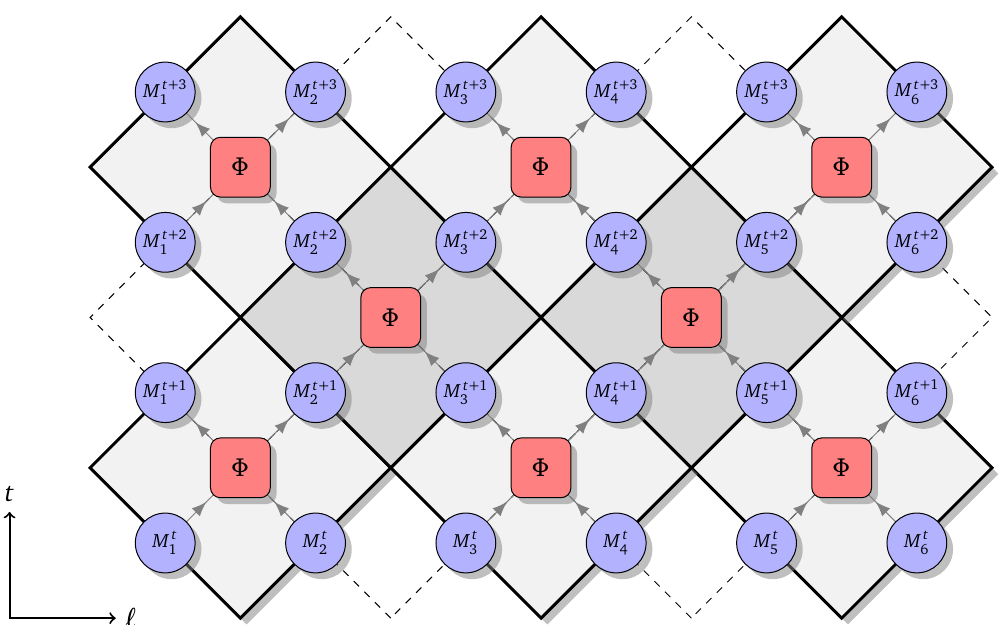
Figure 2: Fabric of discrete space-time: the physical space-time lattice, comprising matrix degrees of freedom M t (blue circles), coexisting with the light-cone square lat- (cid:96) tice depicted by a tilted checkerboard. A two-body symplectic map Φ τ (red square), which is attached to the middle of each tile, provides the time-propagator for every pair of adjacent physical